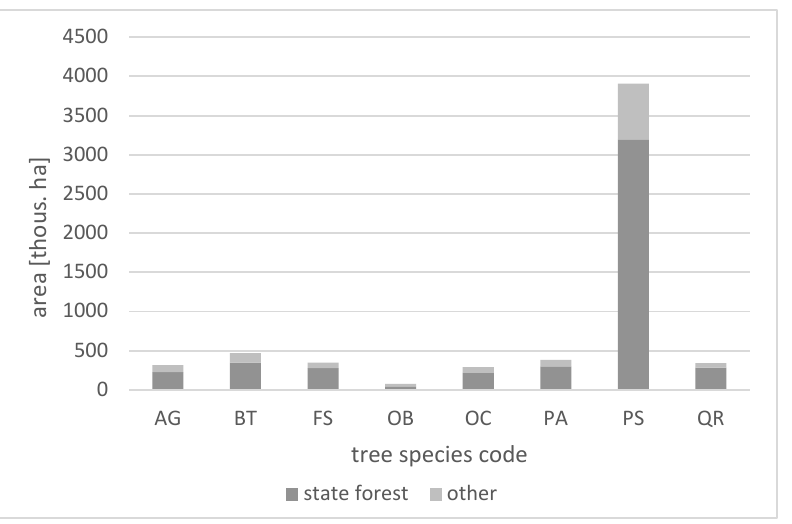
Figure 5. Distribution of leading species selected for EFDM according to the ownership.